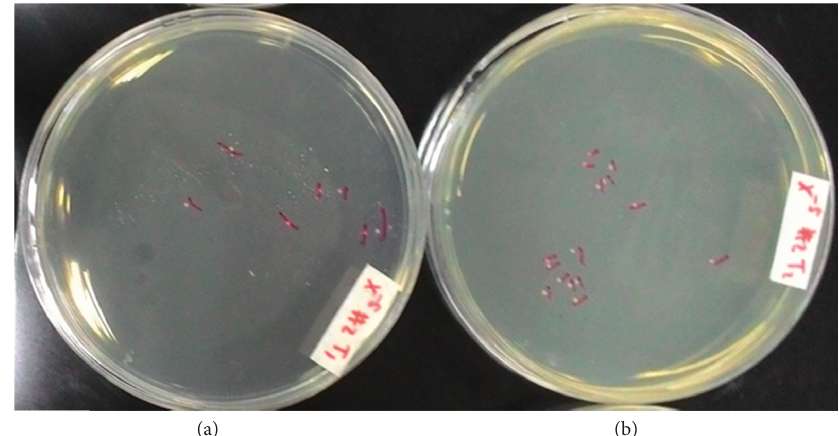
Figure 10: S. aureus colonies diluted 10